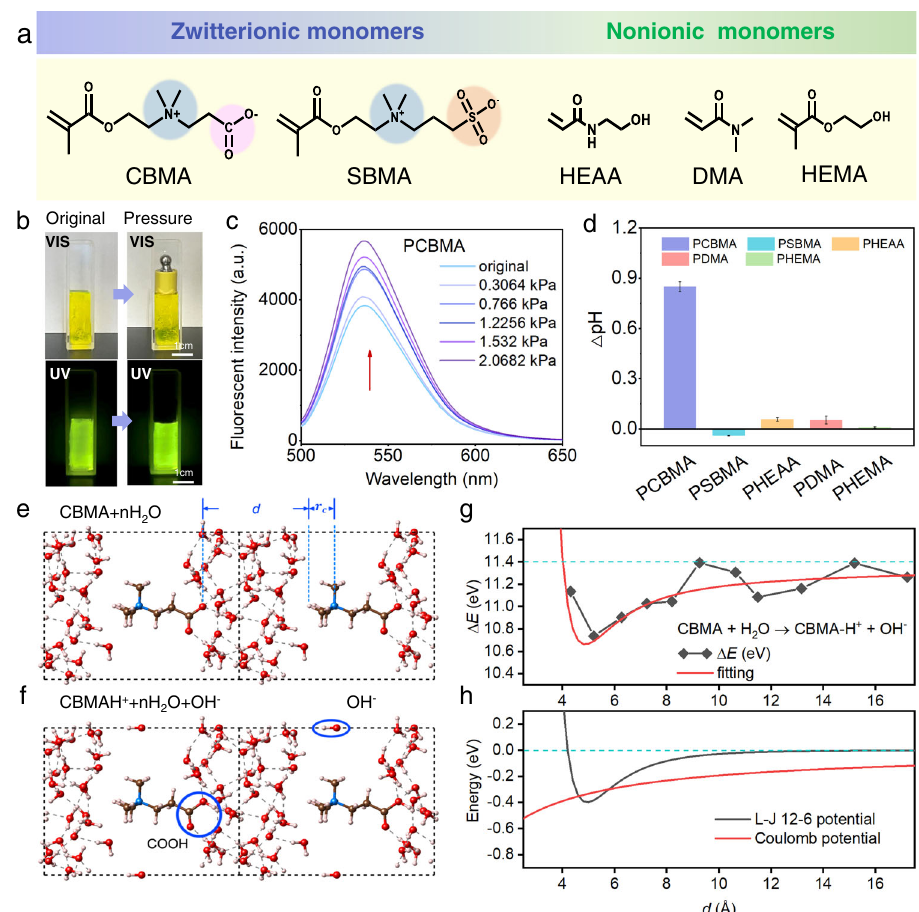
Fig. 2 | Force-induced ion generation in the hydrogels. a Two families of hydrogel monomers (zwitterionic CBMA and SBMA and the nonionic HEAA, DMA, and HEMA) are linked by MBAA, forming hydrogels in a mobile-ion-free system. b Photographs of the PCBMA hydrogel before and after an external force appli- cation under visible light (upper) and ultraviolet light (lower). c Fluorescence emission spectra of PCBMA hydrogel under various stresses (excitation wave- length=490nm). a.u. arbitrary unit. d pH change in hydrogels under a stress of 2.07kPa. The hydrogels are sized 15mm×10mm×10mm. Data are reported as their means±SDs ( N ≥ 3). e Density functional theory results of the PCBMA